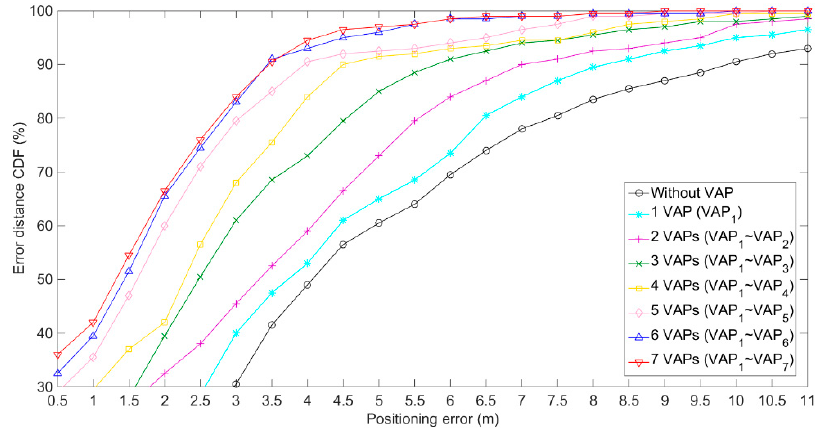
Figure 11. Positioning results of the MA-VAP method for eight different numbers of VAPs. Table 1. Positioning errors of the VAP method and the MA-VAP method at the 90% CDF for eight different numbers of VAPs.